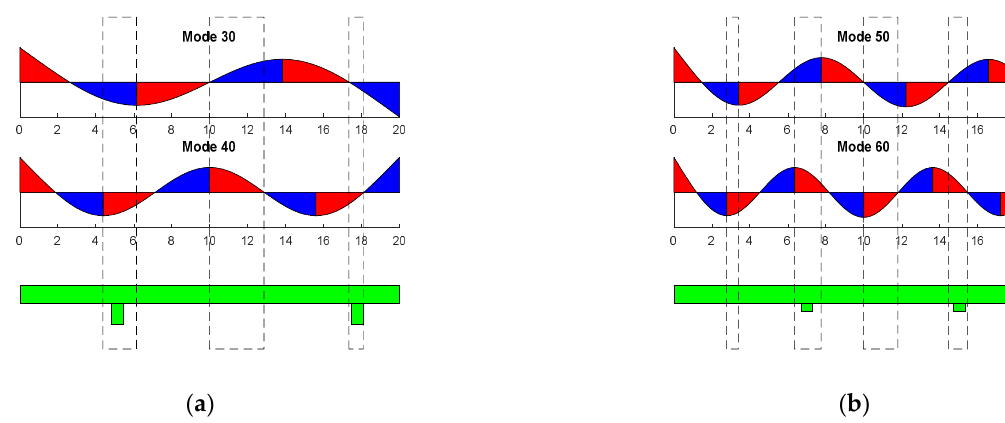
Figure 3. Schematics that show how to determine the location of the legs for standing wave (SW)-based locomotion, assuming a rightward movement with the lowest order mode of each combination. Vertical rectangles show the positions along the length of the device where to locate the legs. ( a ) Low-order combination. ( b ) High-order combination.